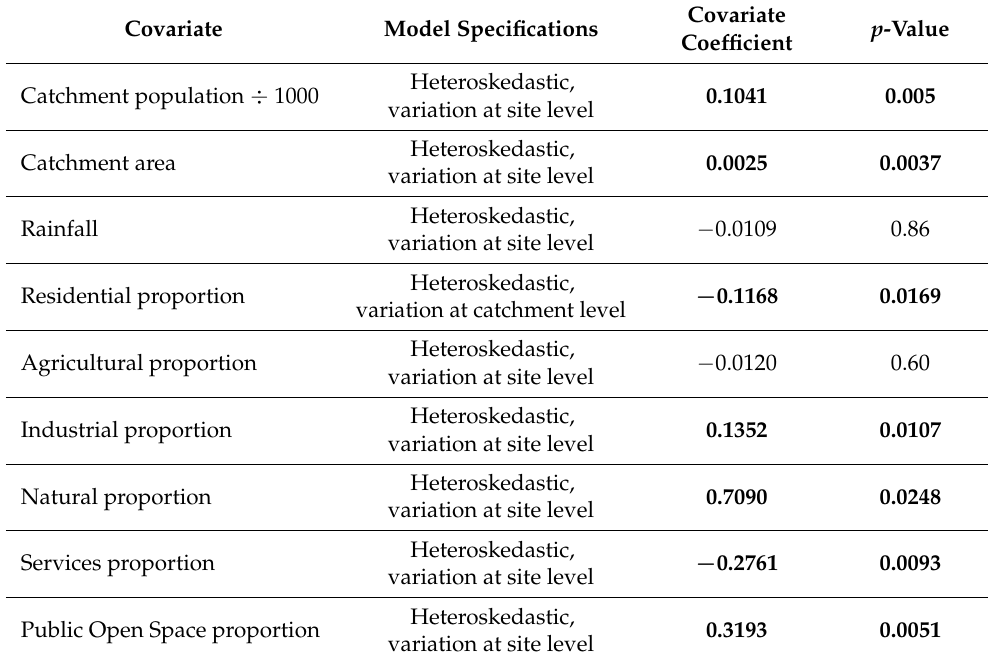
Table 5. Summaries of linear mixed-effects models predicting microplastic concentrations from each of the covariates reflecting the pattern of land use in each catchment. Coefficients and P-values for covariates with significant effects are in bold